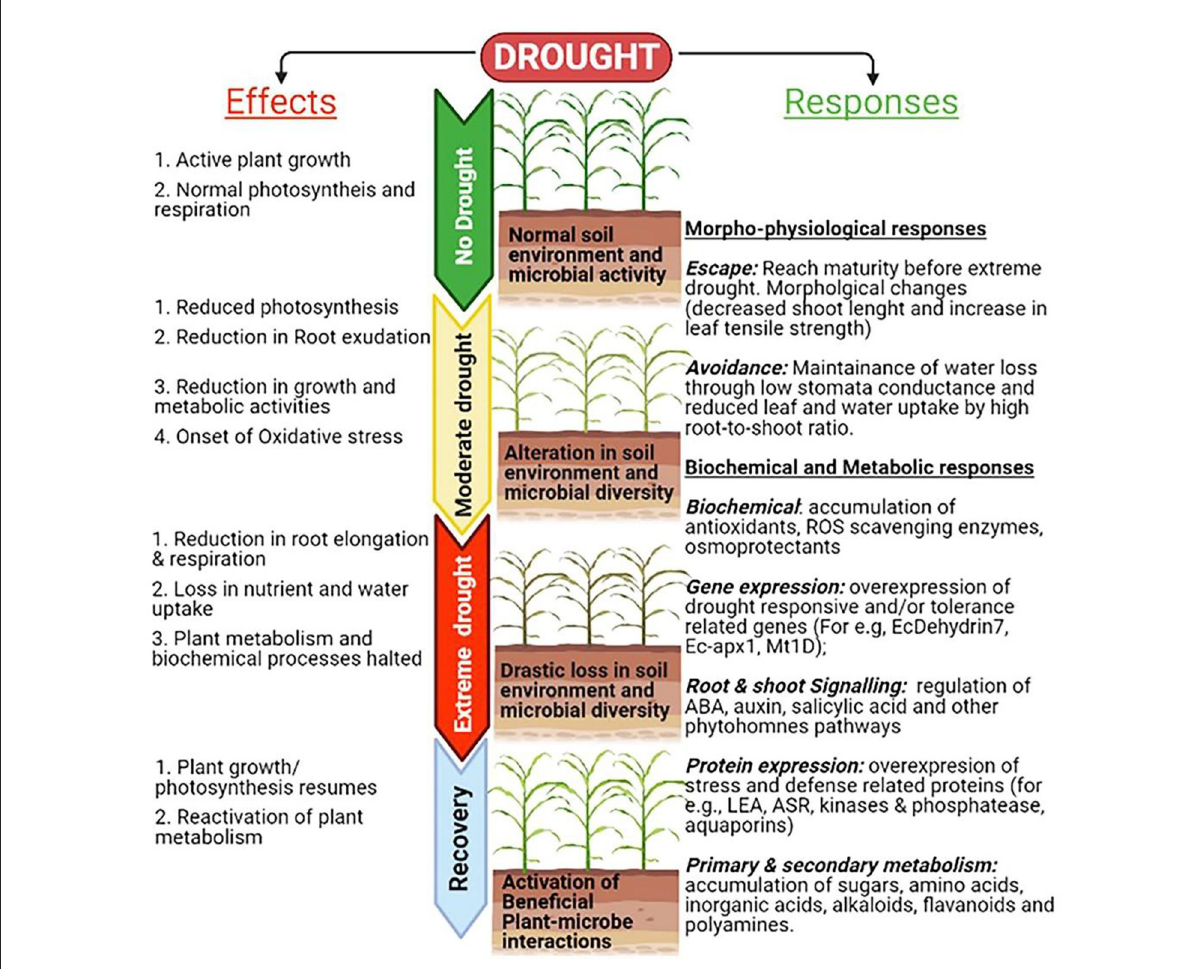
FIGURE3 Drought responses and adaptive strategies linked to numerous morpho-physiological, molecular, and biochemical processes that confer better tolerance to environmental stresses in millets compared to major